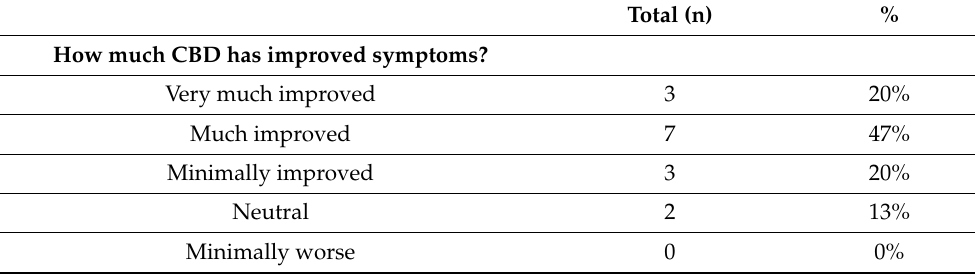
Table 4. Overall improvement from CBD of symptoms and how caregivers would feel if they had to stop CBD use.